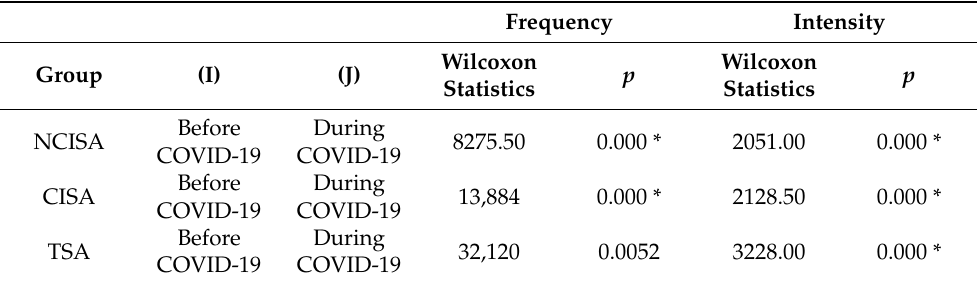
Table 3. Intergroup changes in exercise frequency and intensity from before to during